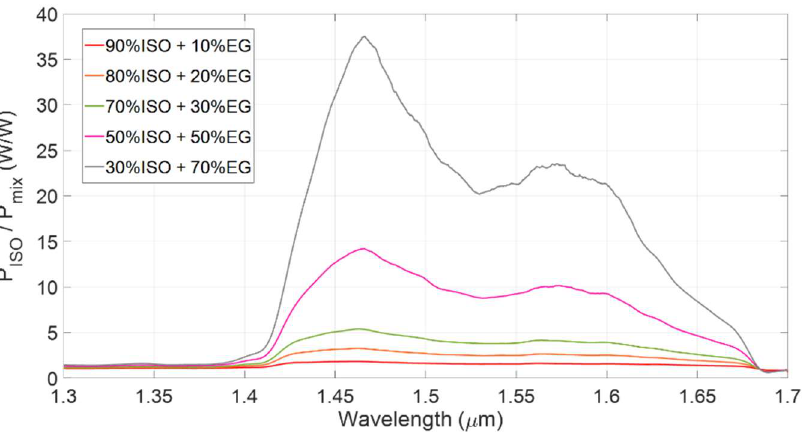
Figure 6. Spectral ratio between the transmitted power collected by flowing into the channel mix- tures of isopropanol with ethylene glycol, in different